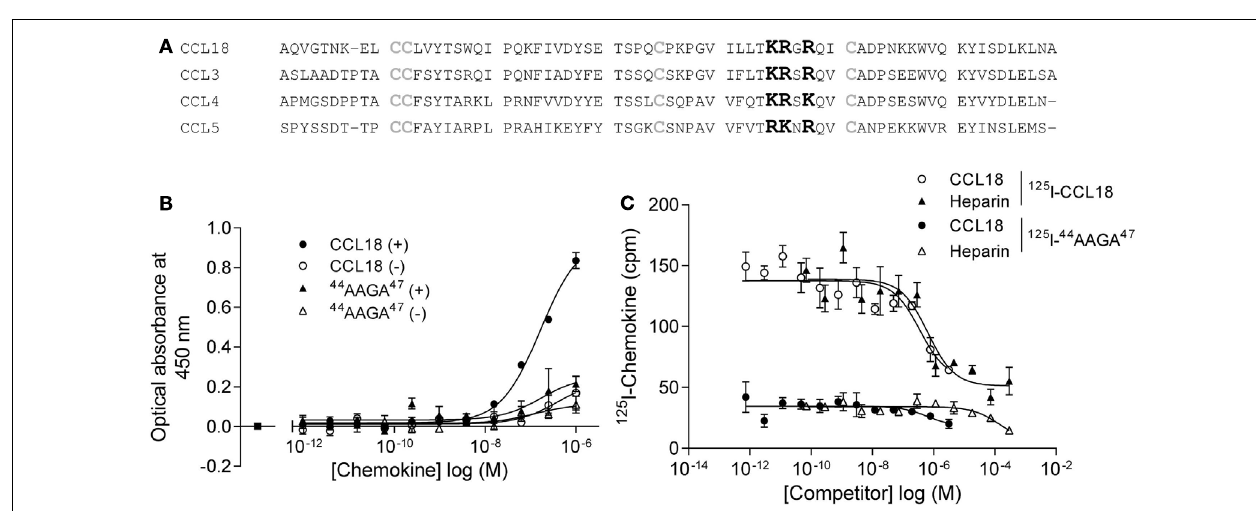
FIGURE 9 | Identification of the BBXB GAG-binding motif in the 40s loop of CCL18 . (A) Prediction of the BBXB GAG-binding motif of CCL18 by a sequence alignment of CCL18 with CCL3, CCL4, and CCL5. Basic residues, which are part of the BBXB motif, are highlighted in bold and the conserved cysteine residues in gray. (B) Comparison of the ability of CCL18 and 44 AAGA 47 -CCL18 to bind to heparin immobilized on Epranex plates. Immobilization of a dilution series of CCL18 and 44 AAGA 47 -CCL18 ( 44 AAGA 47 ) onto a heparin coated ( + ) or uncoated ( − ) heparin binding